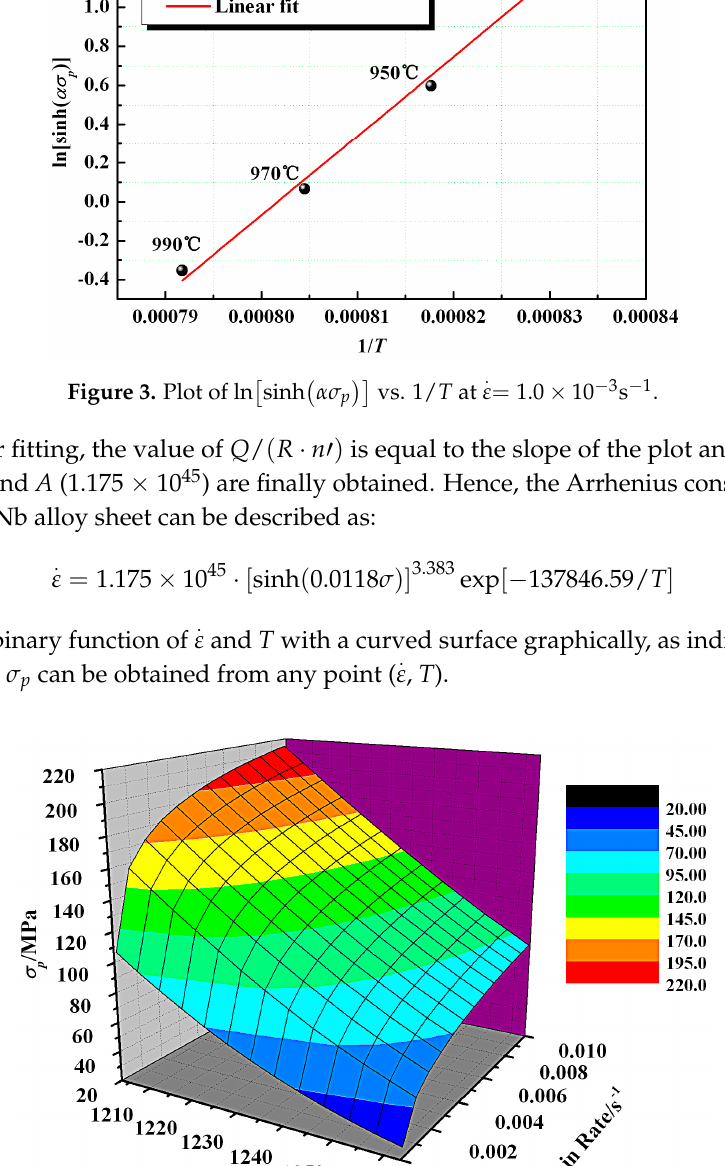
. . ε , T ) function at ε = 2.5 × 10 − 4 ∼ 8 × 10 − 3 s − 1 , T = 930~990 ◦ Figure 4. Graph of σ p -( ε  , T ) function at Figure 4. Graph of σ p -( Figure 4. Graph of σ p -( ε  , T ) function at